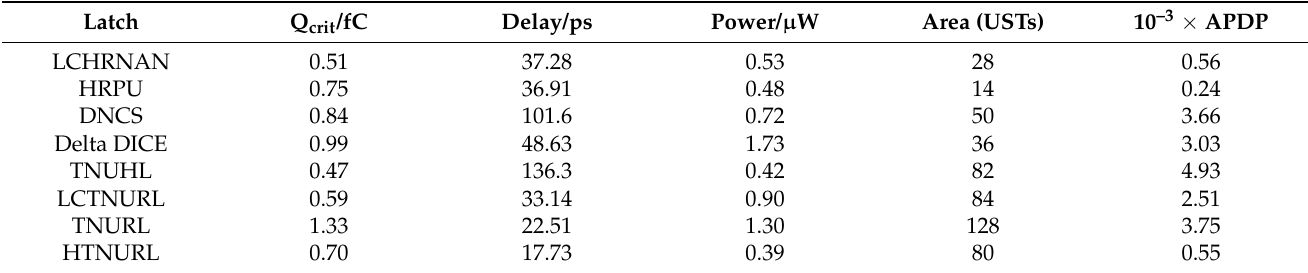
Table 2. Overhead and critical charge comparisons among the typical radiation-hardened latches and HTNURL latch. Latch Q crit